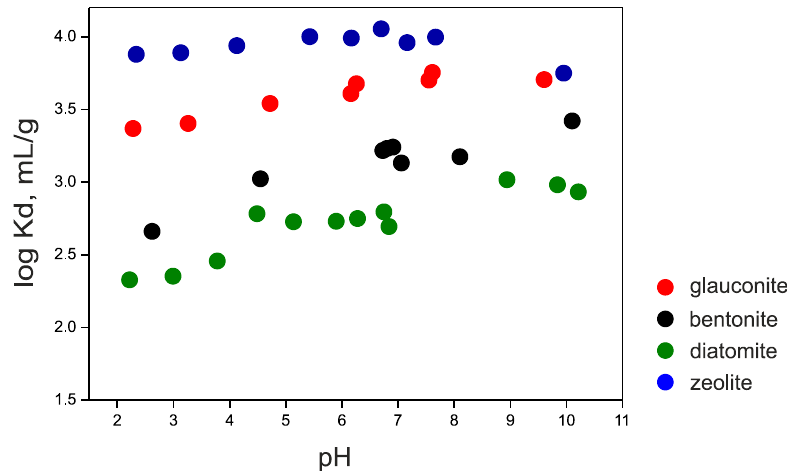
Figure 4. pH-dependence of 137 Cs sorption onto the studied sorbents (( 137 Cs) = 10 − 6 M, (solid phase) = 1 g/L, ionic strength = 0.01 M NaClO 4 ).